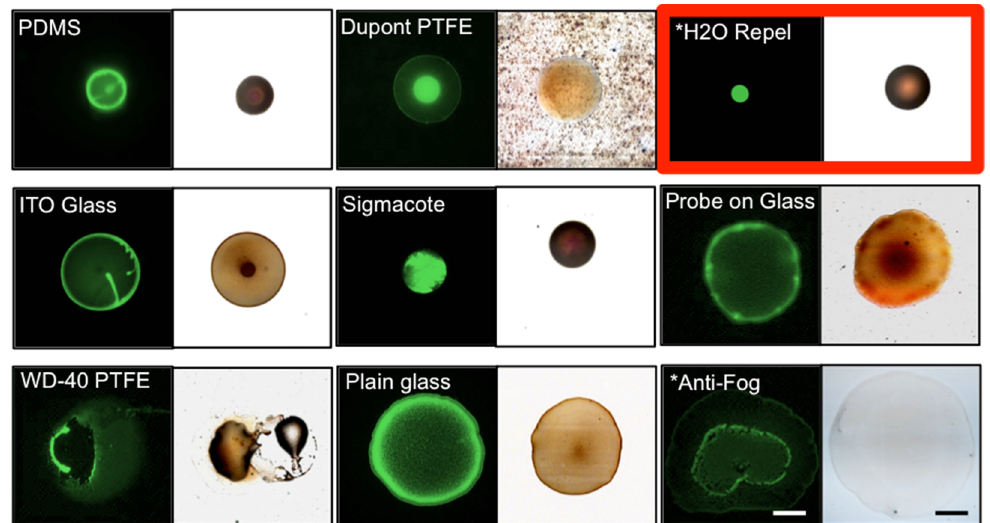
Figure 5. Particle deposition patterns of 2 μ L droplets containing green fluorescent polystyrene particles (left of each pair) or 200 nm magnetic nanoparticles (right of each pair) in order of decreasing contact angle. Theory states that Marangoni flows in all droplets are oriented radially inward along the substrate, with the exception of ITO, which is oriented radially outward along the substrate. Because of the strong central deposition pattern, we selected Water Repellent Rain-X ® (H2O Repel) to covalently coat microscope slides, creating our solid substrate. Scale bar = 500 µ m, n = 3. * Indicates Rain-X ® product.